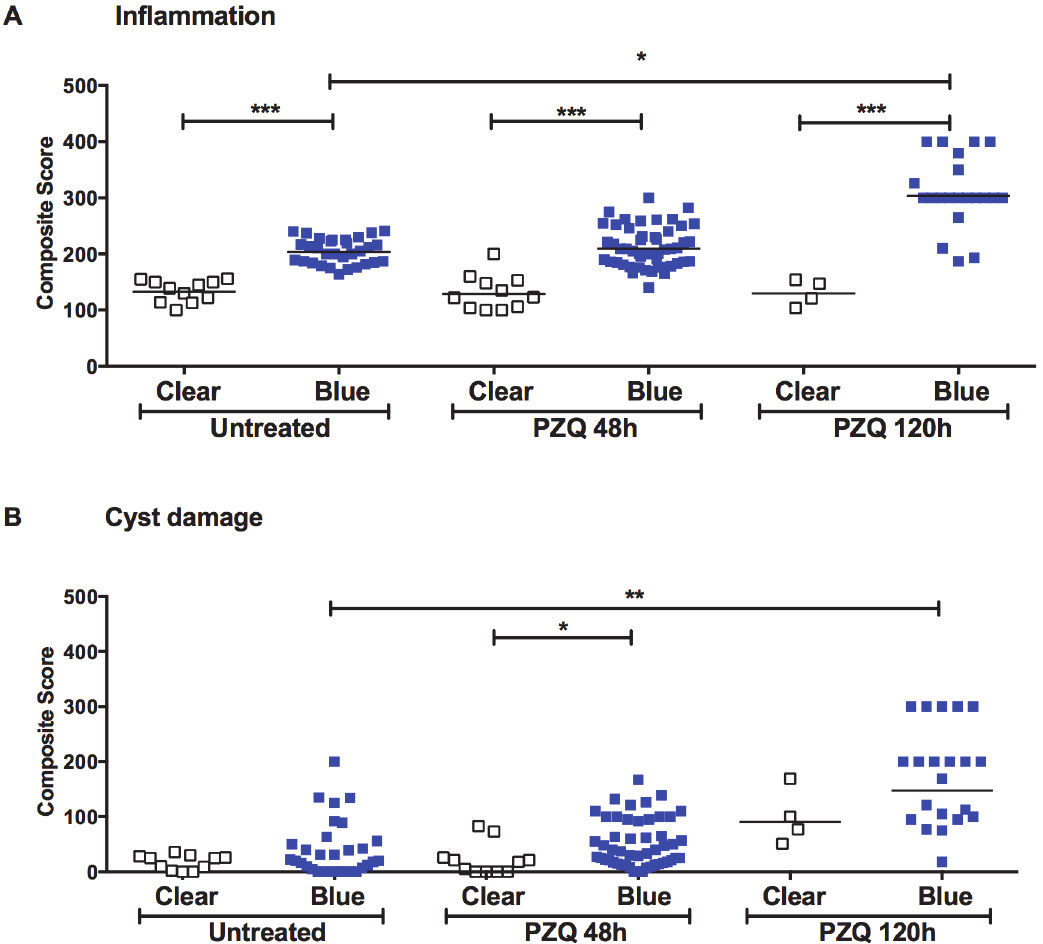
Fig 2. EB capsules show increased inflammation and cyst wall damage compared to clear capsules. Cysts were harvested from the brains of infected untreated pigs (n = 3; see Methods) or pigs treated with PZQ 48h (n = 4) or 120h (n = 4) earlier. For each cyst, scores reflecting the degree and extent of the inflammatory cell infiltrates (A) and cyst wall damage (B) at 48h (PZQ 48h) and 120h (PZQ 120h) after PZQ treatment (see Methods and S1 Fig.) are shown (open squares refer to clear capsules and closed squares, to EB capsules, bar = mean). Statistical significance in comparison between groups is represented by asterisks ( * : p < 0.05; ** : p < 0.01; *** : p <